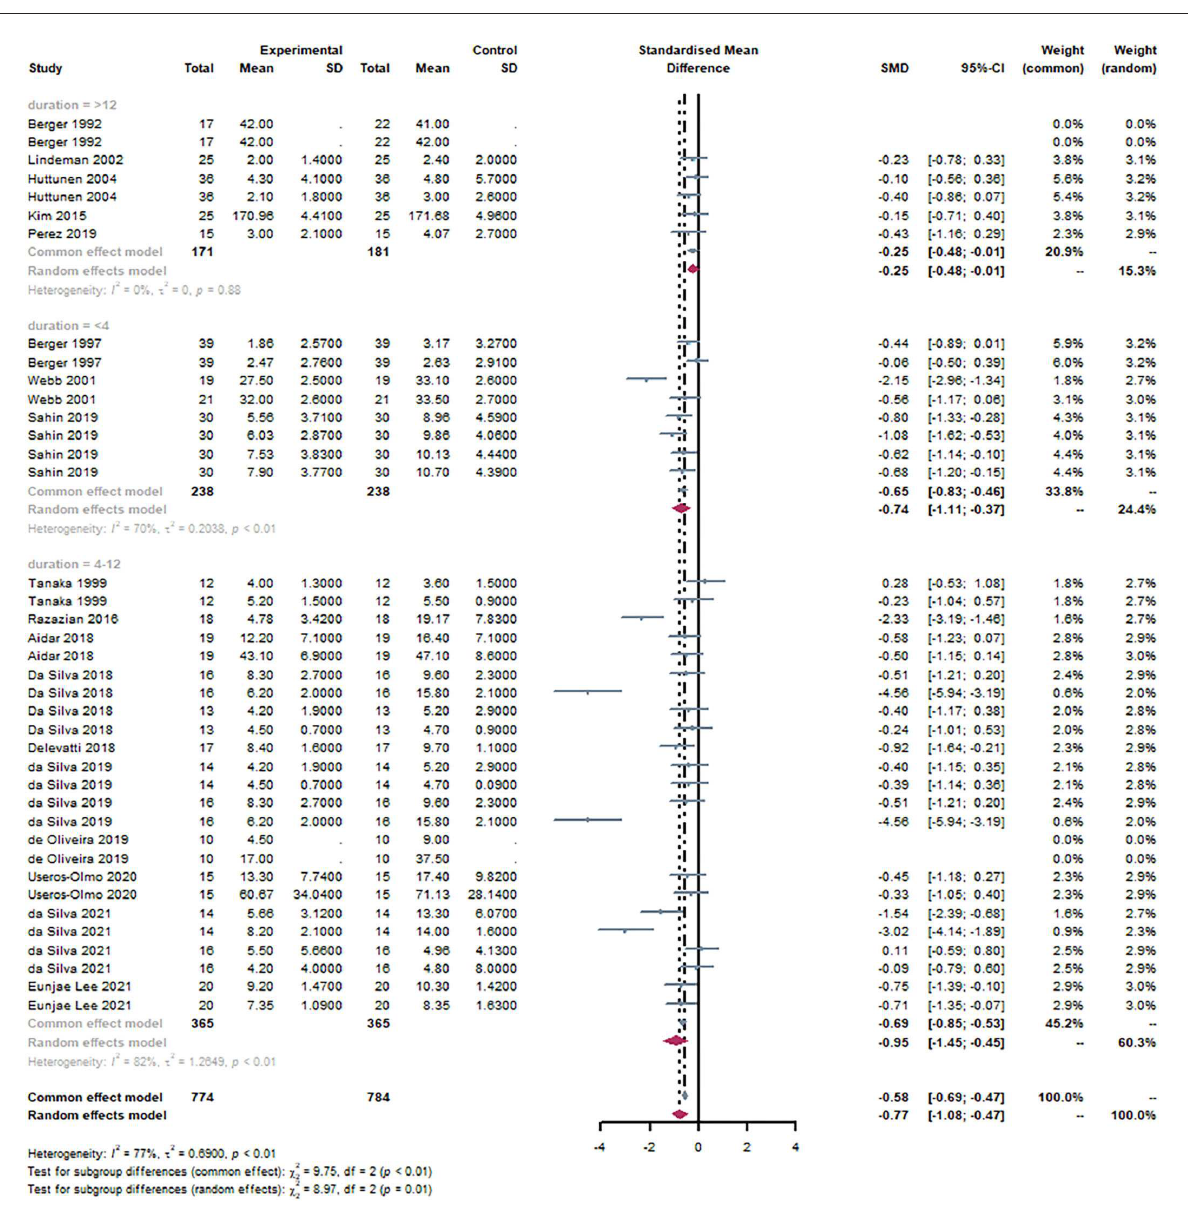
FIGURE9 Forest plot of duration of exercise. By subgroup analysis of the disease, < 4 weeks [SMD = − 0.74, 95% CI ( − 1.11, − 0.37), I 2 = 70%, P < 0.01] and 4–12 weeks [SMD = − 0.95, 95% CI ( − 1.45, − 0.45), I 2 = 82%, P < 0.01] were statistically significant through the subgroup